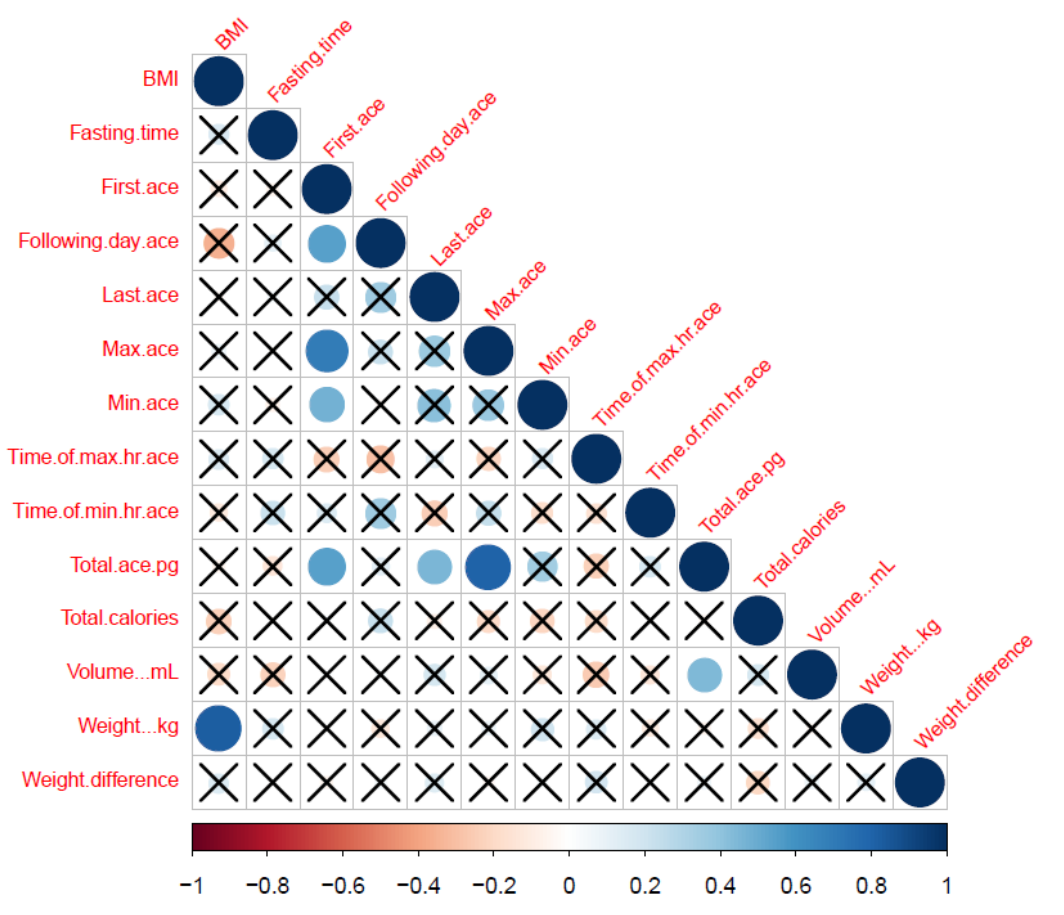
Figure 2. Correlation Matrix for ACE derived and other relevant dieting parameters. Correlations between the variables (shown in Table 1). They were scaled from 1.0 to − 1.0. Blue indicates positive correlation while red indicates negative correlation. X indicates no correlation between the two parameters which is significant at p = 0.01. The size of the circles corresponds to the strength of the correlation. The bigger the circle, the stronger is the correlation between 2 variables.